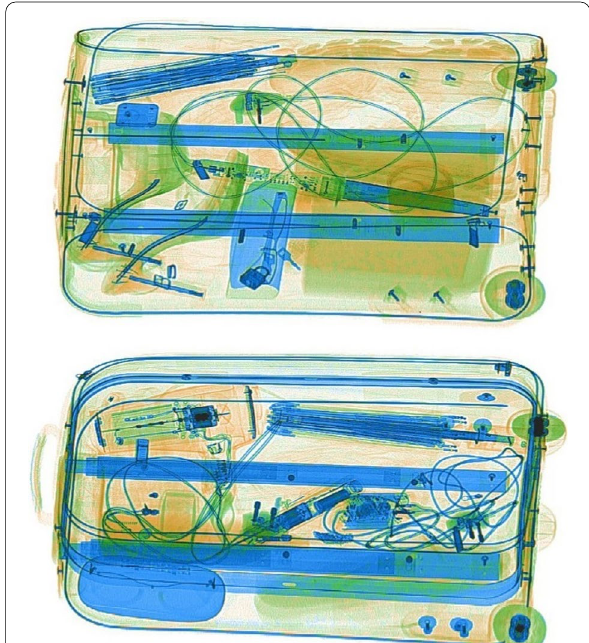
Fig. 7 Stimuli from the CaSePIX image library (not used in the present study) illustrative of the levels of spatial overlap present in stimuli with greater overlap used in the test phases of Experiments 3 and